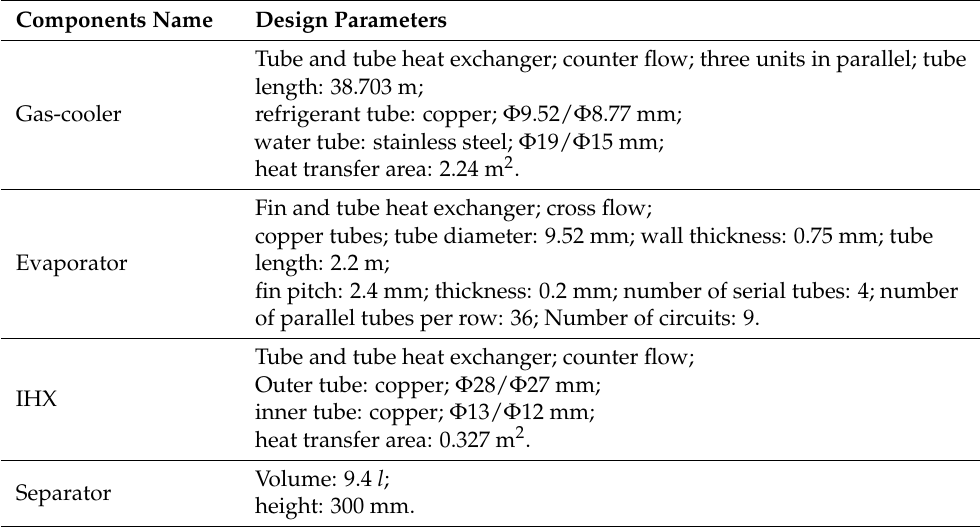
Table 1. Design specifications of major components of the transcritical CO 2 thermal management system.